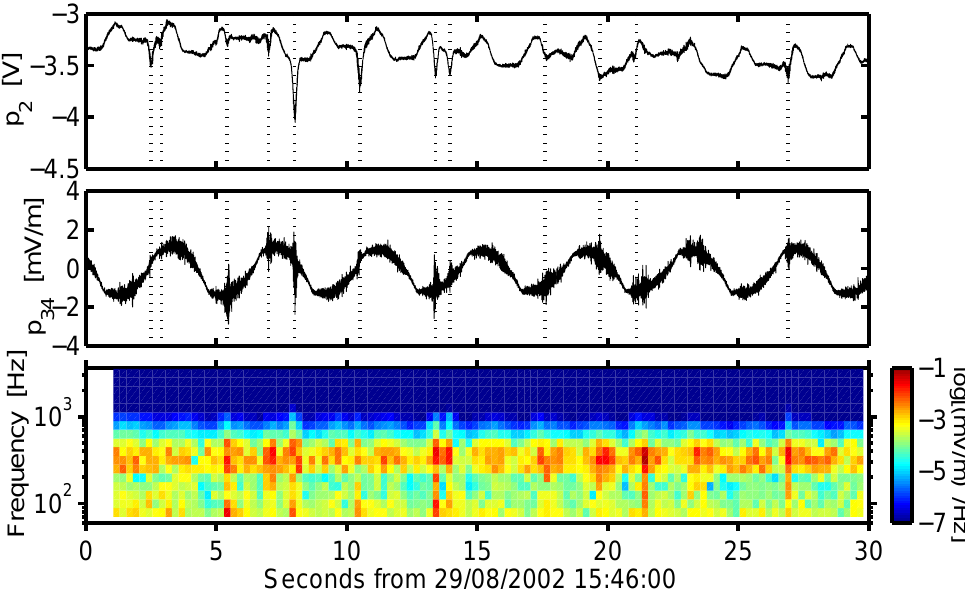
Fig. 2. Typical example of LHCs observed by Cluster 1. The upper panel shows high resolution observations of the potential of probe 2 with respect to the spacecraft, which can be used as an estimate of the density (a decrease in this parameter indicates a decrease in the density). The regular increases of this potential every 2s are caused by asymmetries in the spacecraft and the 4s spin. The middle panel displays the electric field measured between probes 3 and 4 with a 180Hz low-pass filter. The satellite spin is obvious in this panel. The bottom panel gives an electric field spectrogram up to 4kHz. The lower hybrid frequency is about 240Hz, and the identified LHCs are indicated by dotted